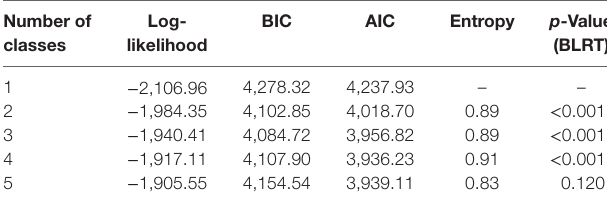
Table 5 | Indices for latent class analysis models with 1–5 latent classes.